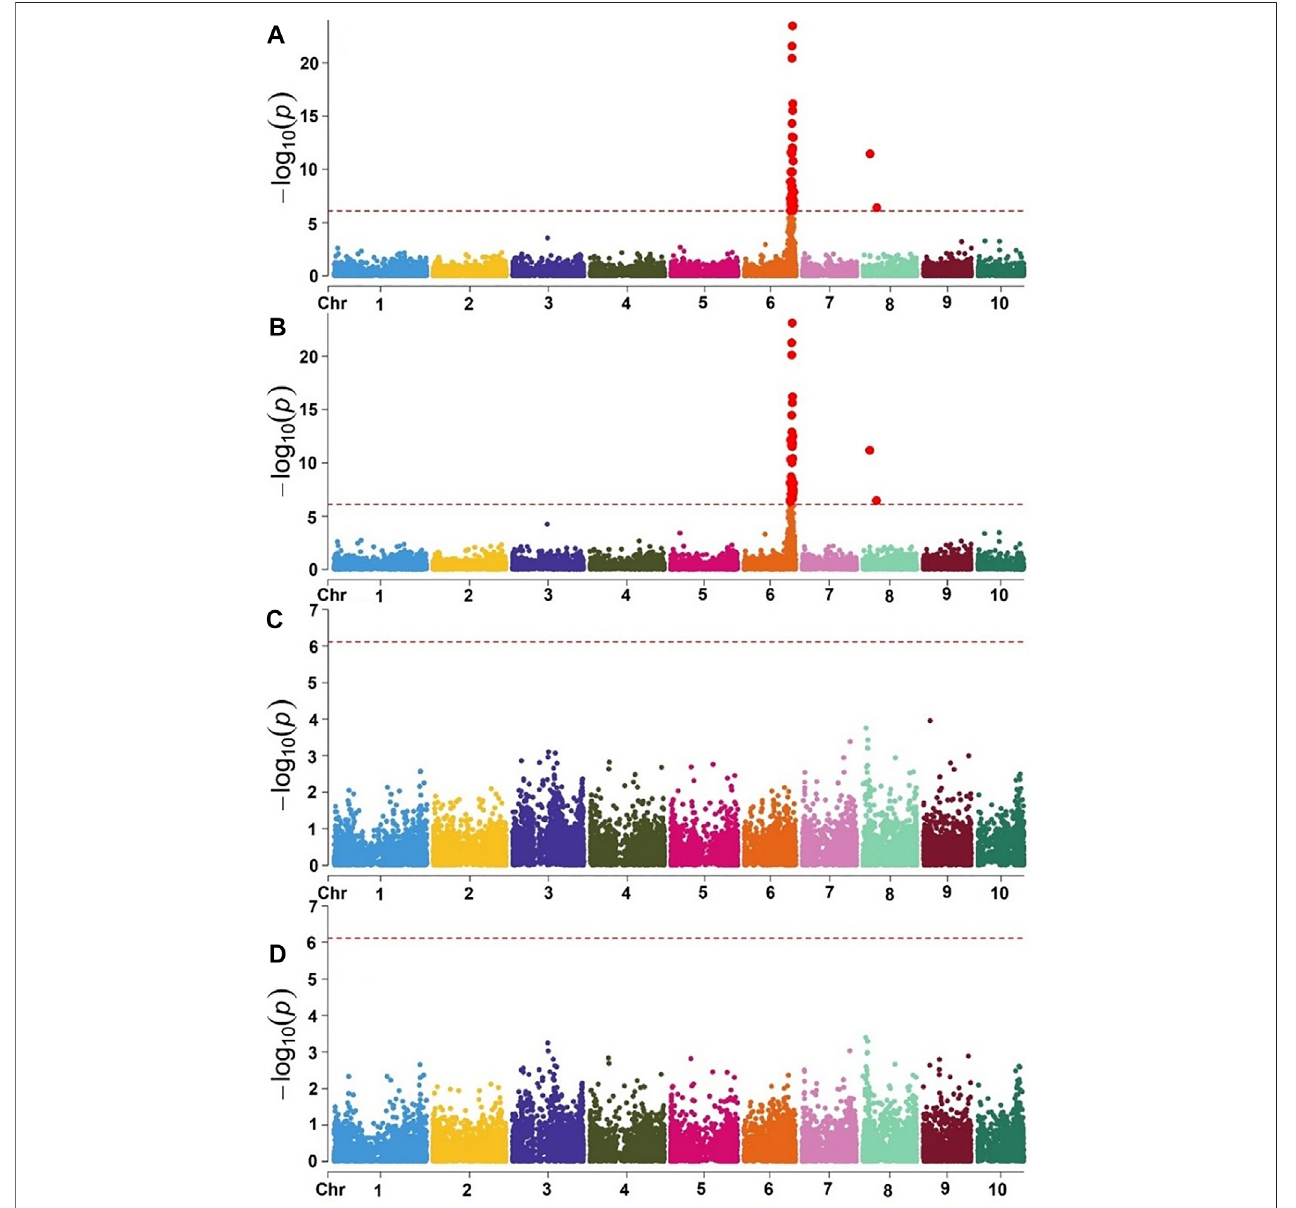
FIGURE 5| Manhattan plot of GWAS using MLM in the selective genotypingpopulations. Combined genome-wide association scan for MLN_DS (A) and AUDPC values (B) based on the fi rst three F2 populations (SG) with KS23 background. Manhattan plots for MLN_DS (C) and AUDPC values (D) based on two F2